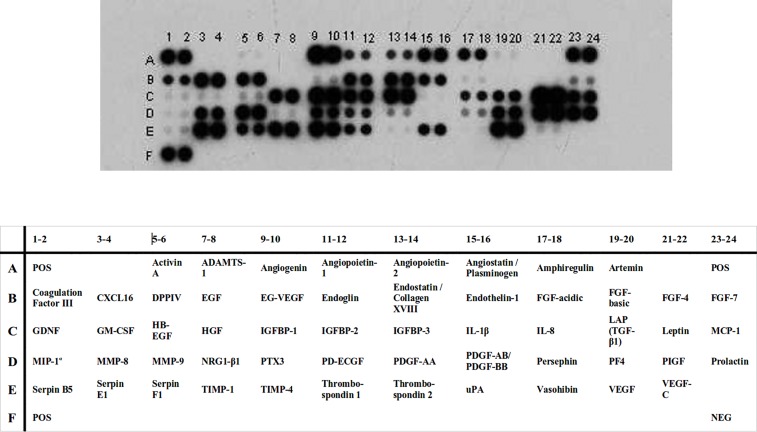
Angiogenic profile of patient with ovarian cancer.Demonstration of the angiogenic profile determined in the ascites of a patient with ovarian cancer using the Proteome Profiler Angiogenesis Array kit. Each spot corresponds to an angiogenic factor shown in Table 1.